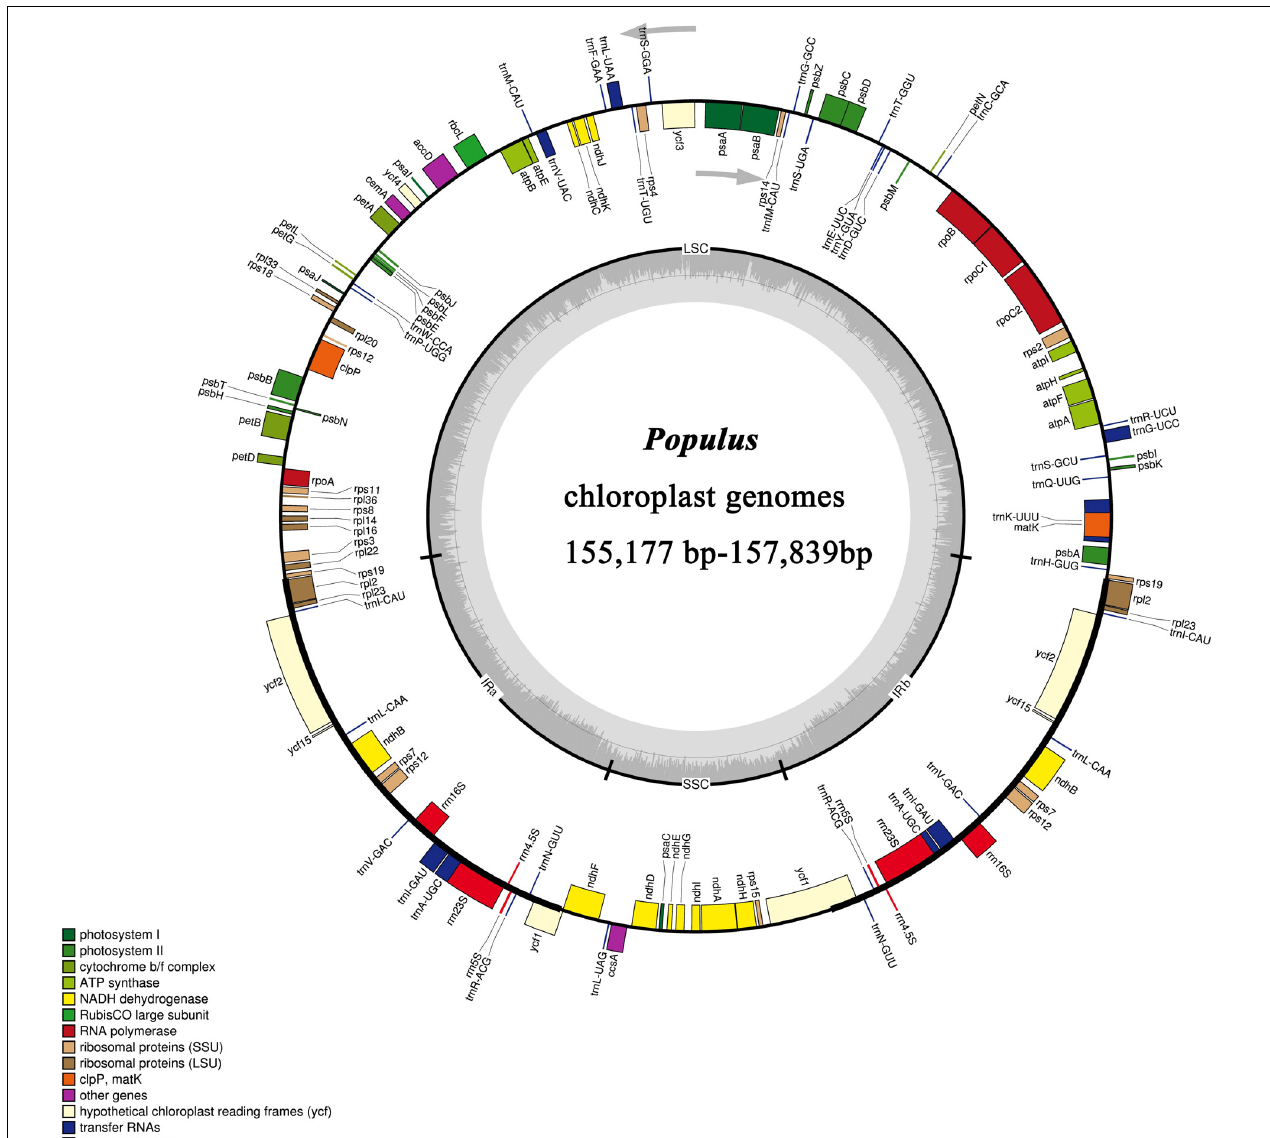
FIGURE 1 | Gene map of 24 Populus chloroplast genomes. Genes inside the circle are transcribed clockwise and genes outside the circle are transcribed counter clockwise.